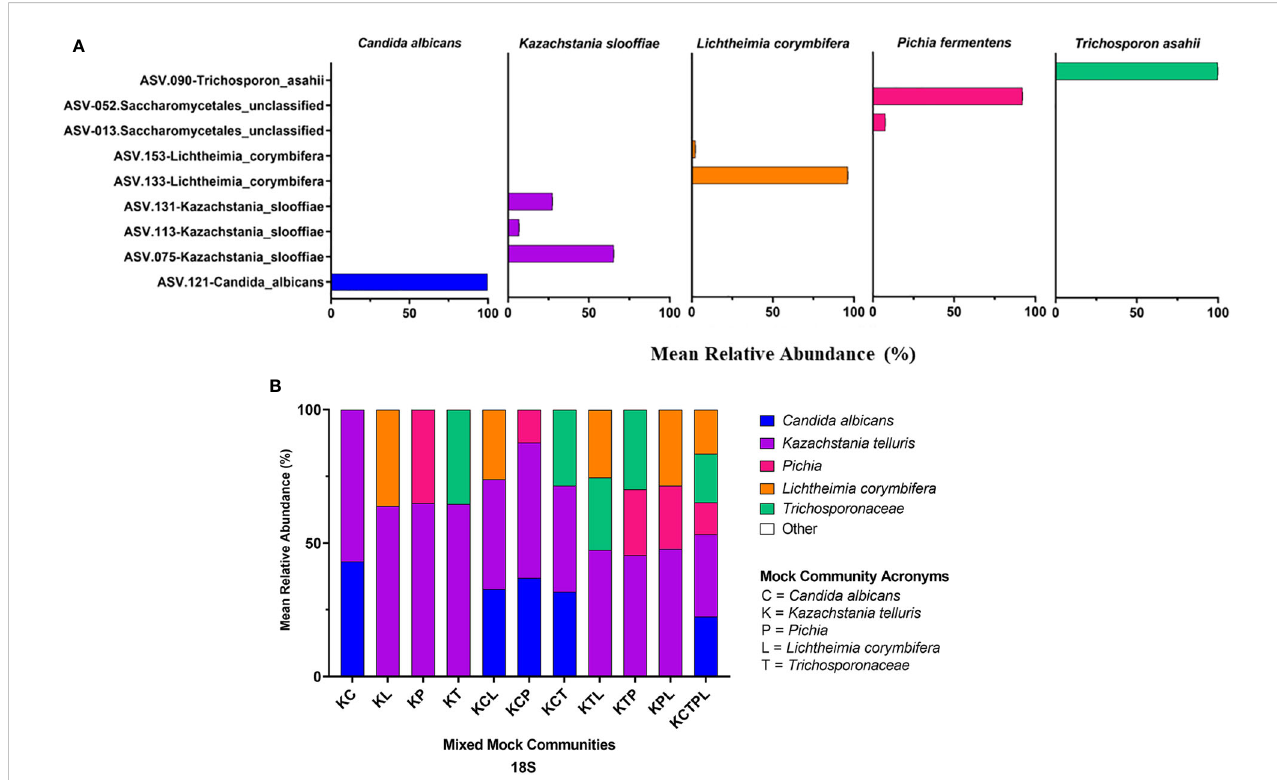
FIGURE 3 ITS1 Sequencing Results. ITS primers were used to sequence individual fungal isolates; C albicans, K sloof fi ae, L. corymbifera, P. fermentans , and T. asahii (A) or mock communities ranging from 2 isolate combinations up to all 5 in one mock community (B) . Each mock community is represented on the x axis with an acronym representing the fungi in the mock community. C, Candida albicans ; K, Kazachstania telluris ; P, Pichia ; L, Lichtheimia corymbifera ; and T, Trichosporonaceae . Combinations are represented with the fi rst letter of each fungus found in each mock community, for example, KC, Kazachstania and Candida . Negative controls for PCR reactions are found in the supplemental